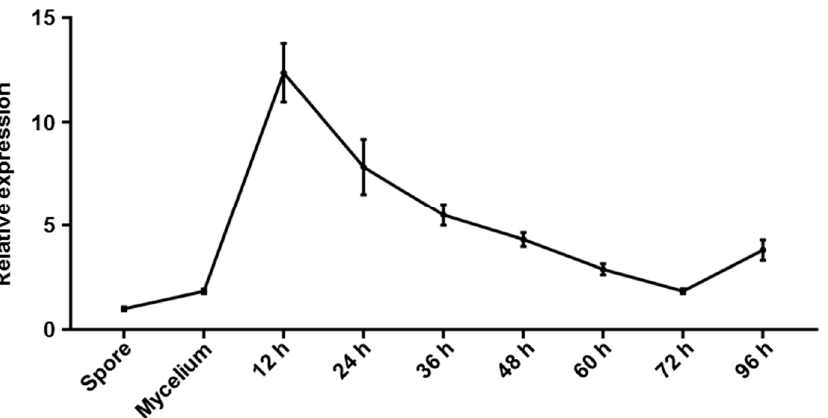
Figure 3. Expression pattern of CgGPI7 at different stages. Samples from vegetative (spore and mycelium) and invasive stages (12, 24, 36, 48, 72, and 96 hpi) of infected maize leaves were collected and the expression patterns of CgGPI7 were quantified via qRT-PCR. CgGPI7 was especially induced at the initial infection stages. The bar represents the standard deviation of the three technical duplications.